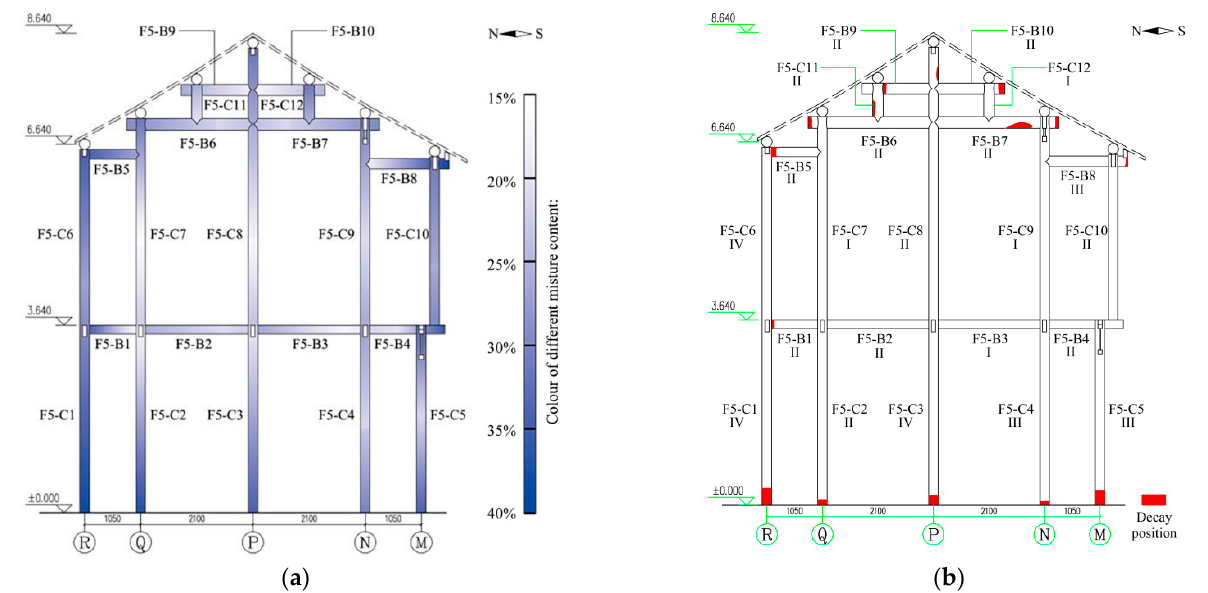
Figure 16. Moisture content and decay of F5 in Fujiu Zhou house; ( a ) schematic diagram of moisture content; ( b ) schematic diagram of decay position and decay grade.